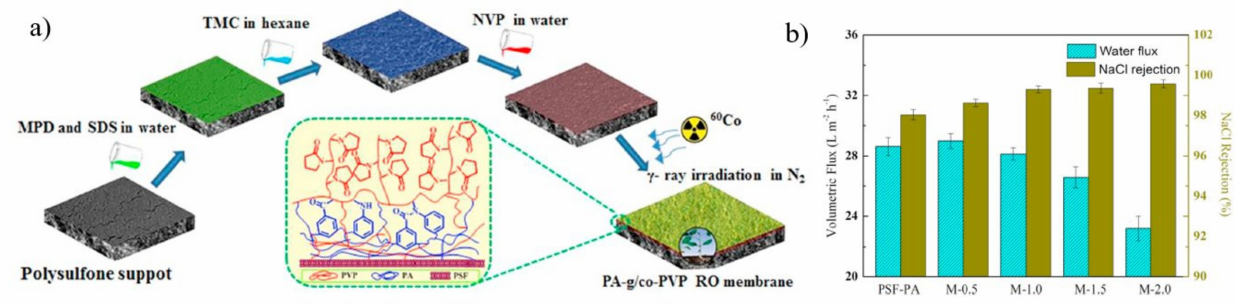
Figure 15. ( a ) Schematic overview of fabrication process for PA-g/co-PVP RO membranes via multistep interfacial polymerization; ( b ) Volumetric flux and salt rejections of nascent membranes PSF-PA and PA-g/co-PVP RO membranes M-0.5, M-1.0, M-1.5, and M-2.0 (cross-flow velocity 0.19 m/s; 2000 ppm NaCl feed solution; 25 ◦ C; pH 7.0; and TMP15.5 bar) (M-0.5 to M-2.0 shows various PVP loading, where M-0.5: 0.5 kg/m 3 PVP, M-1.0: 1.0 kg/m 3 PVP, M-1.5: 1.5 kg/m 3 PVP, M-2.0: 2.0 kg/m 3 PVP)